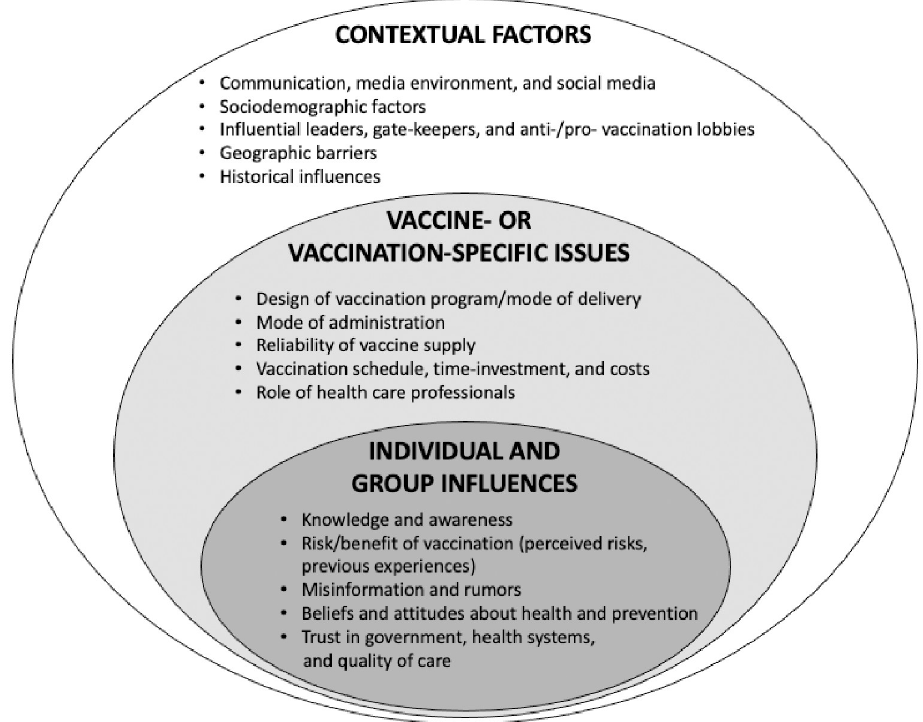
Fig 1. A matrix of the determinants of vaccine hesitancy in India adapted from the Matrix of Hesitancy Determinants by the Strategic Advisory Group of Experts on immunization (SAGE).